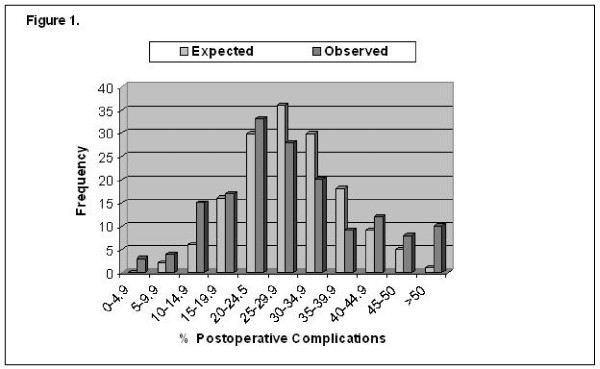
Histograms juxtapose observed and expected number of surgeons' postoperative complications. More outliers on right side of histogram in observed vs. expected plot highlight providers achieving poor outcomes. On the other hand, outliers toward left in observed vs. expected plots indicate surgeons achieving more favorable outcomes (From Bianco, J Urol, 2005, copyright permission).